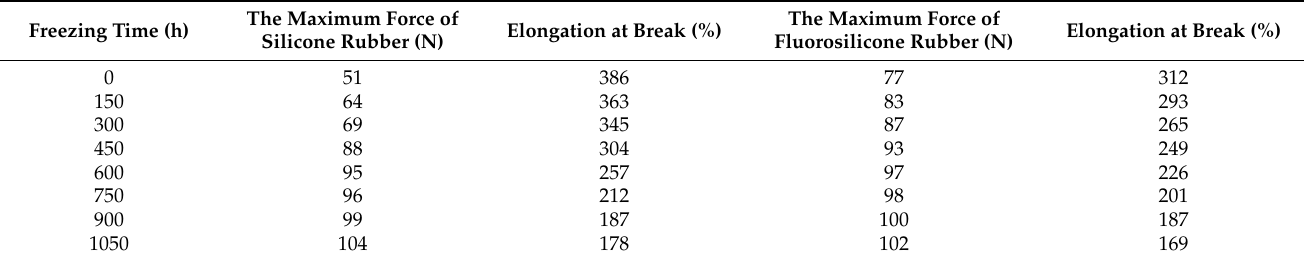
Table 3. Maximum force and elongation at break.